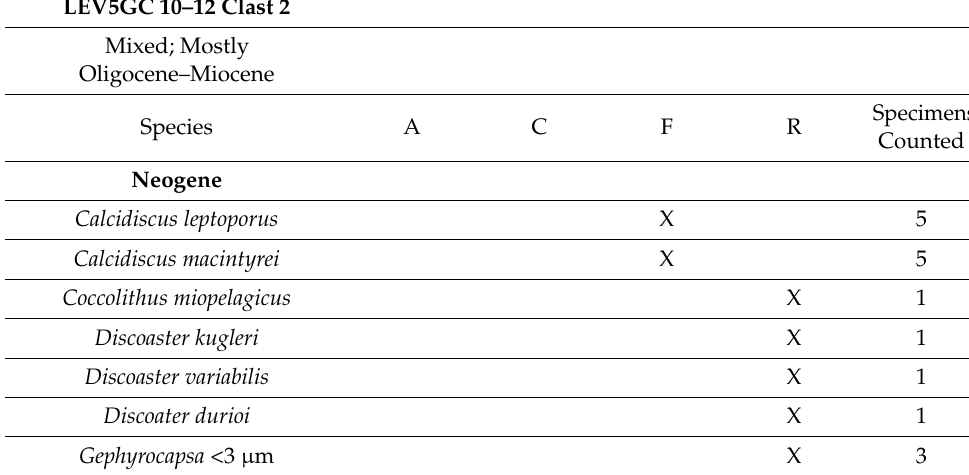
Table A19. Moscow